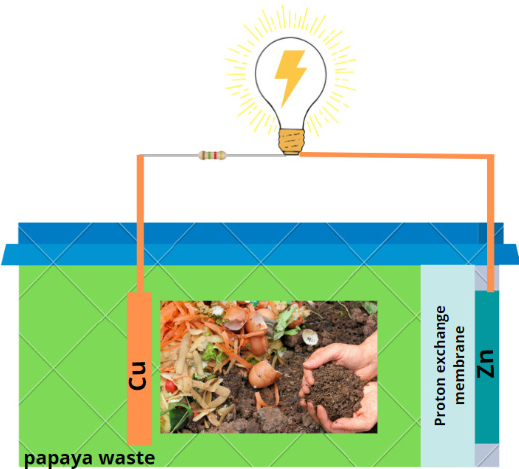
Figure 1. Schematization of microbial fuel cells.